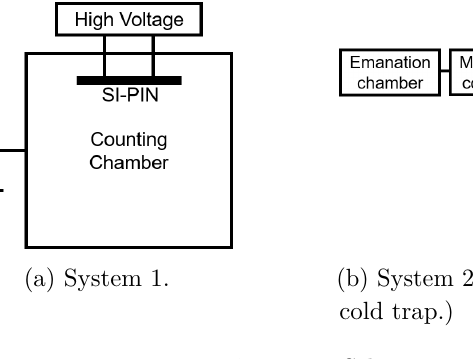
Figure 6. Schematics of radon emanation